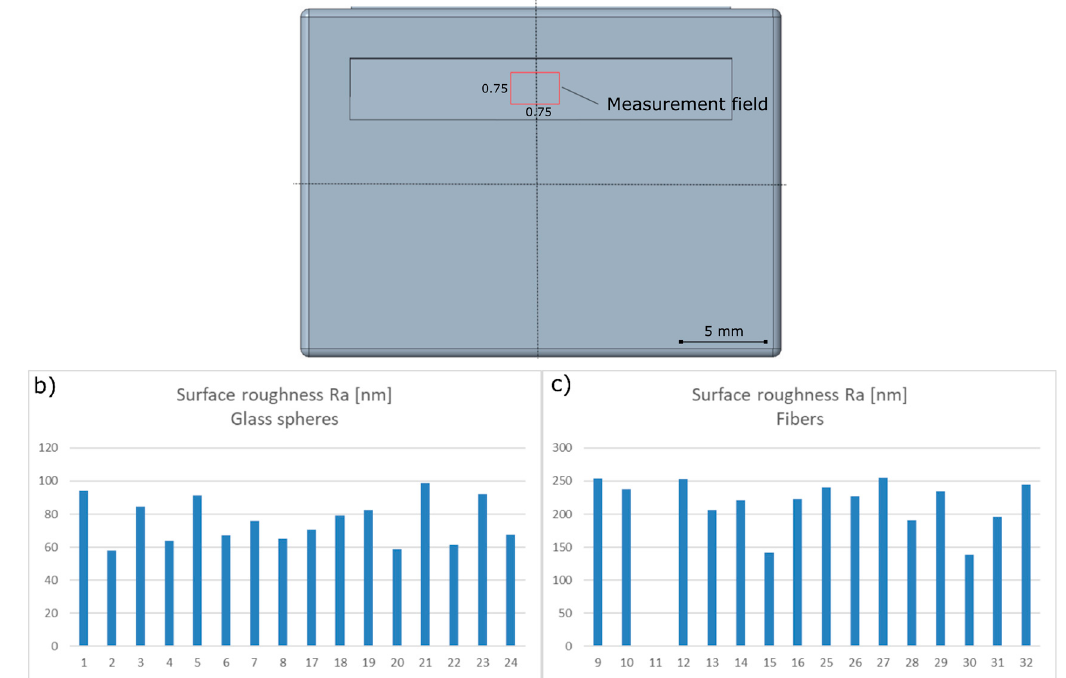
Figure 5. ( a ) measurement field for surface roughness Ra using WLI. ( b ) Ra values of glass sphere filled material with a standard deviation of 13.1 nm. ( c ) Ra values of fiber filled material with a standard deviation of 36.0 nm.